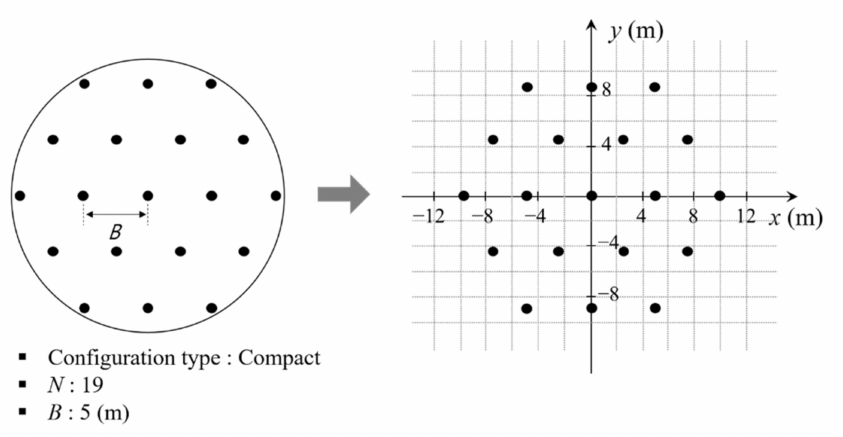
Figure 3. Example of BHE coordinates for calculating the total distance according to Equation